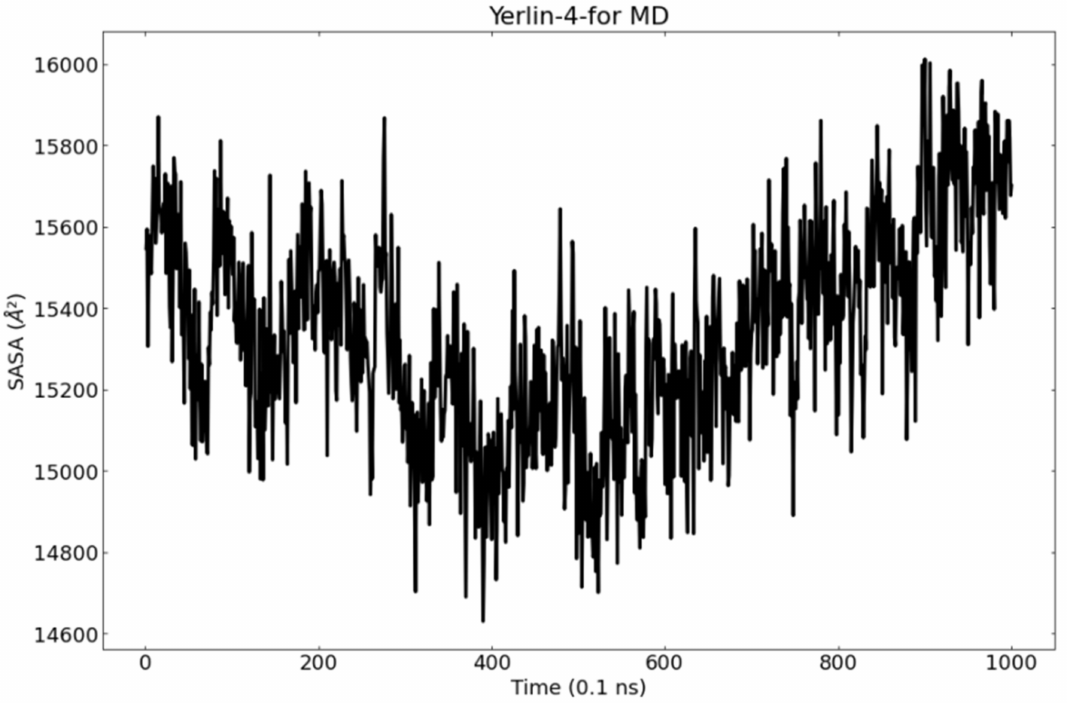
Figure 16. SASA of M pro in the MD